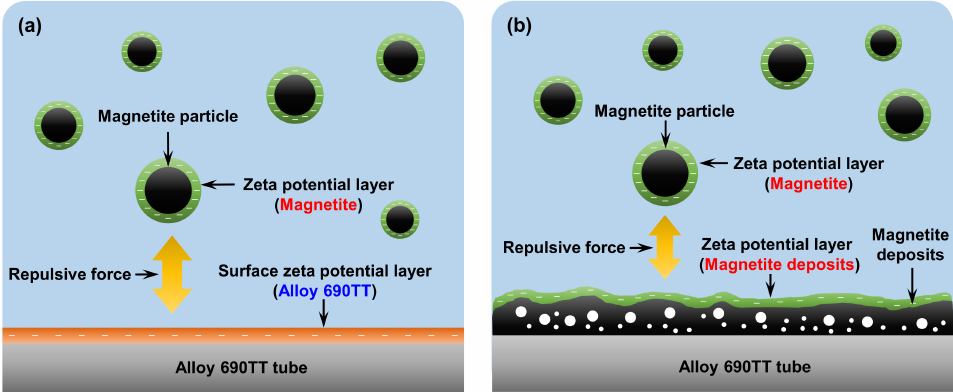
Figure 15. Schematic diagram of the magnetite deposition behavior on Alloy 690TT tube: ( a ) initial stage and ( b ) the following